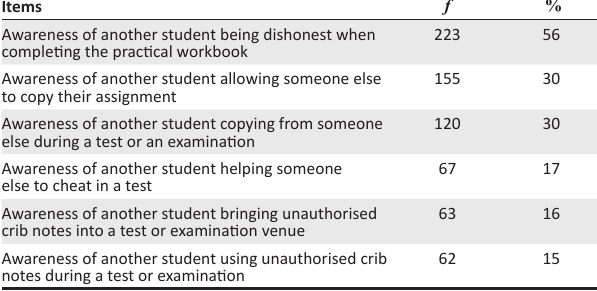
TABLE 2: Awareness of cheating behaviours by